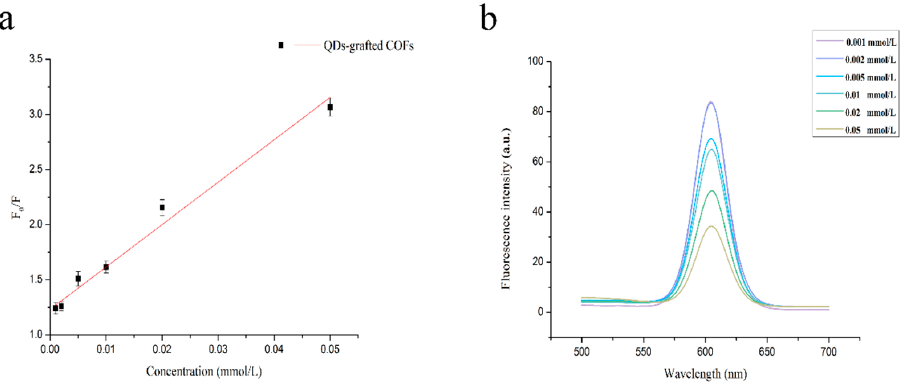
Figure 4. ( a ) Stern–Volmer plot of QCA concentration and ( b ) fluorescence intensity of QDs-grafted